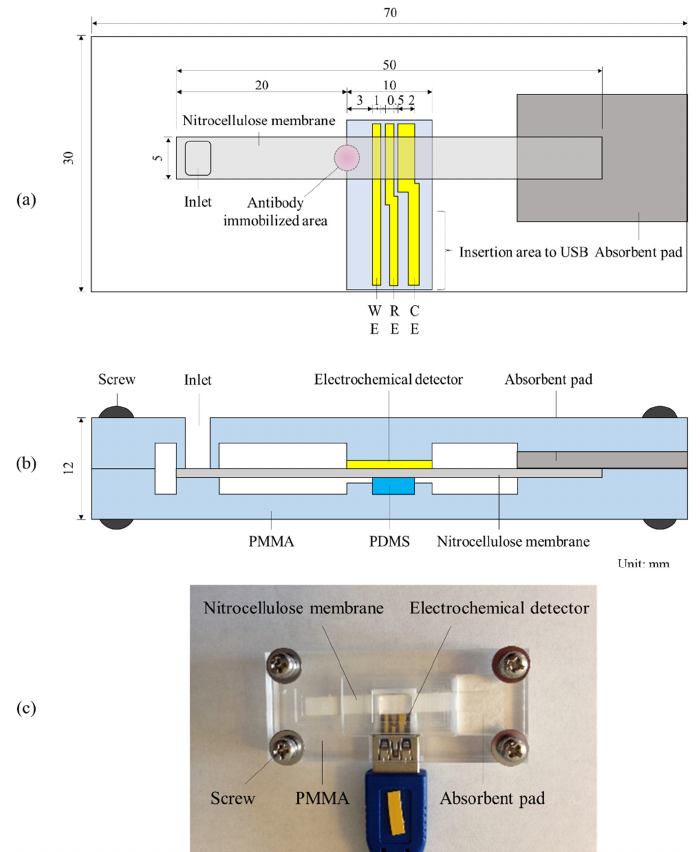
Figure 1. Electrochemical immunochromatography platform. ( a ) The layout of the nitrocellulose membrane and electrochemical detector. ( b ) Schematic of cross-sectional view. ( c ) Photograph of top